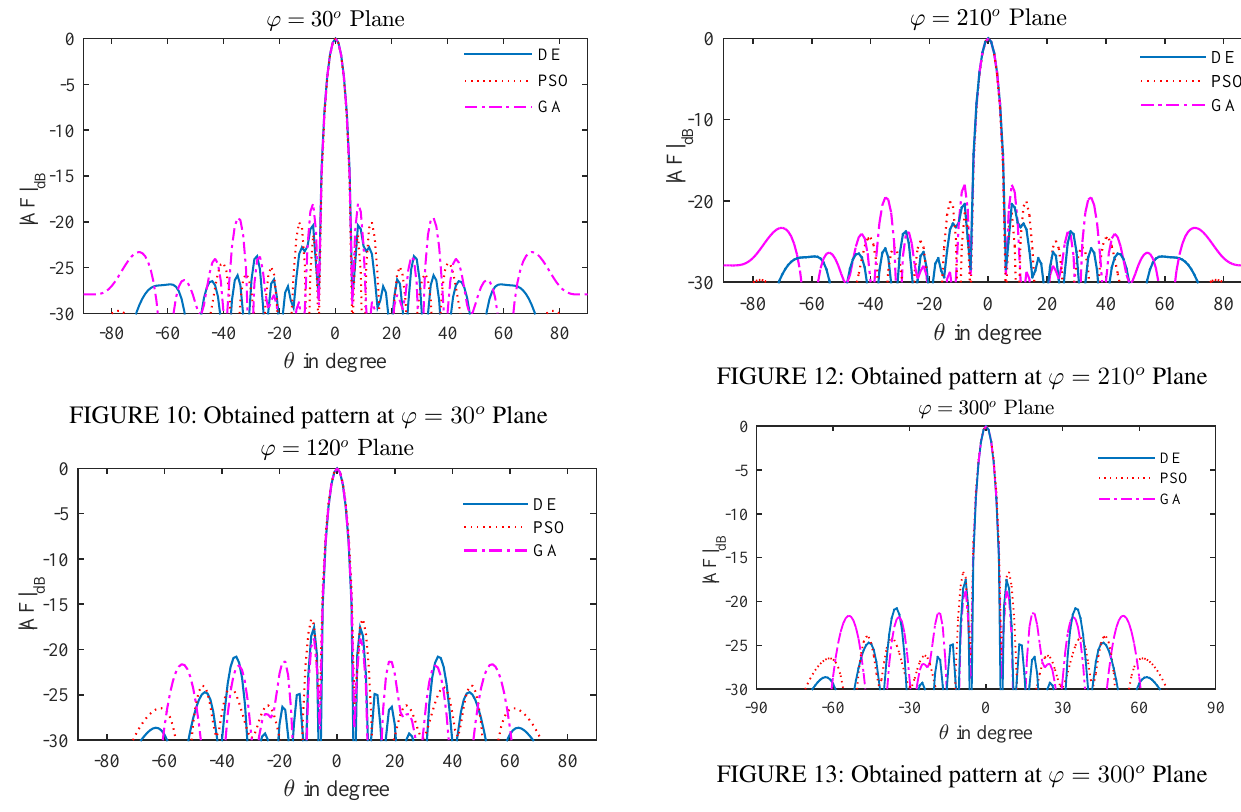
FIGURE 12: Obtained pattern at ϕ = 210 o Plane